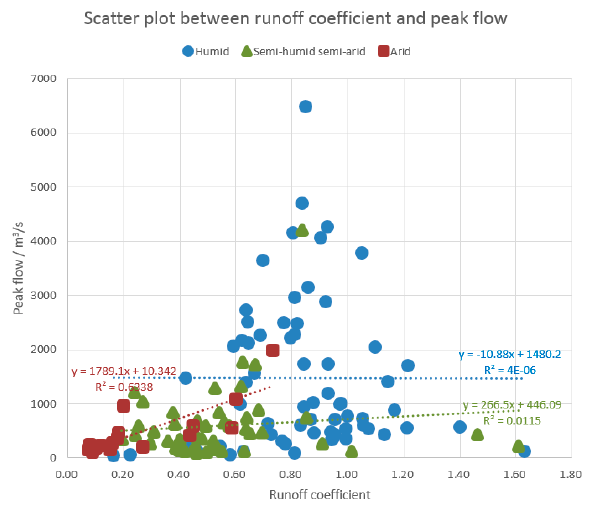
Figure 4. Scatter plot between runoff coefficient and peak flow.